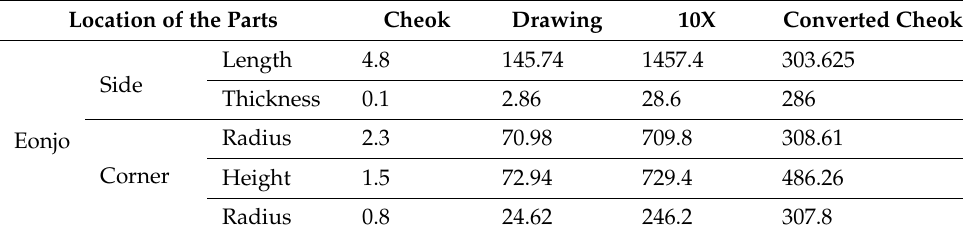
Table 7. Comparison of dimensions of the side and corner parts of Eonjo. Location of the Parts Cheok Drawing 10X Converted Cheok Length 4.8 145.74 1457.4 303.625 Side Thickness 0.1 2.86 28.6 286 Radius 2.3 70.98 709.8 308.61 Eonjo Corner Height Radius Table 8. Comparison of dimensions of other parts of Eonjo. Location of the Parts Cheok Drawing 10X Converted Cheok 0.47 13.4 134 285.11 1 29.52 295.2 295.2 0.2 Dimensions of other parts 245 of Eonjo